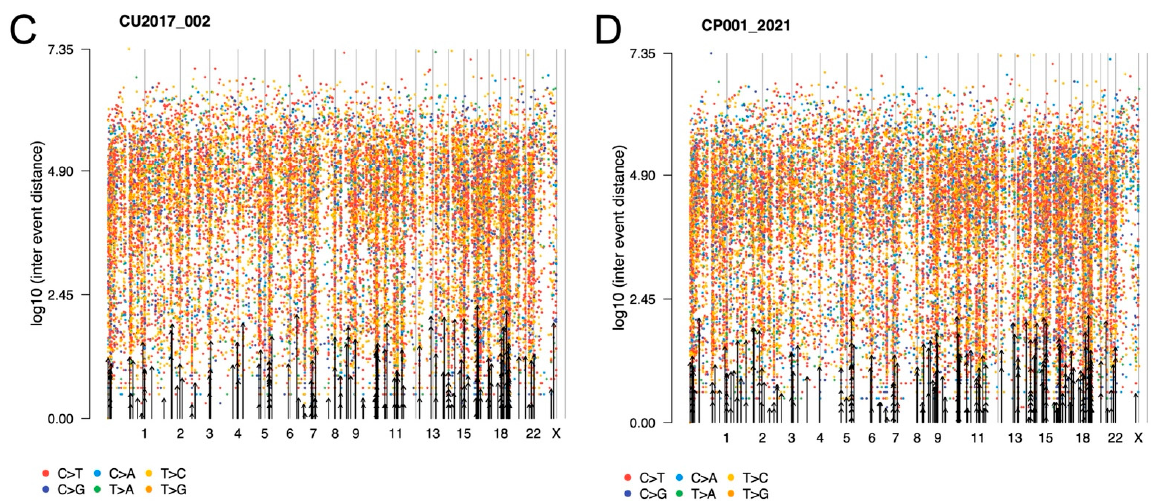
Figure 2. Representative rainfall plots showing the SNV alterations throughout the whole genome of corticotroph tumors ( A ) CCA, ( B ) SCA, ( C ) CD and ( D ) ACTH-CA, displaying all base changes, including transversions and transitions. No kataegis events were found. Alterations across the genome were seen in all corticotroph tumors. In general, the pituitary CA presented more CNV alterations than the benign tumors, with 27 and 32 cytogenetic regions showing gains and losses of genetic material, respec- tively. The cytogenetic regions showing gains were 10q11.22, 15q11.2, 16p12.3, 1p13.2 and 20p, where genes SYT15, POTEB, ARL6IP1, HIPK1 and CJD6 are coded, respectively. By contrast, 8p21.2 was the cytogenetic region showing loss of genetic material. The previ- ously reported amplification of 1p13.2 was also detected in this tumor (Figure 4) [10].